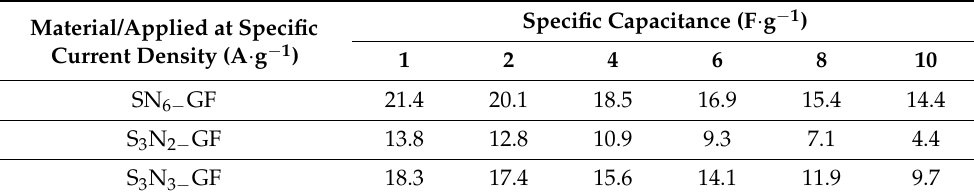
Table 5. Summary of specific capacitance values obtained for the different co-doped